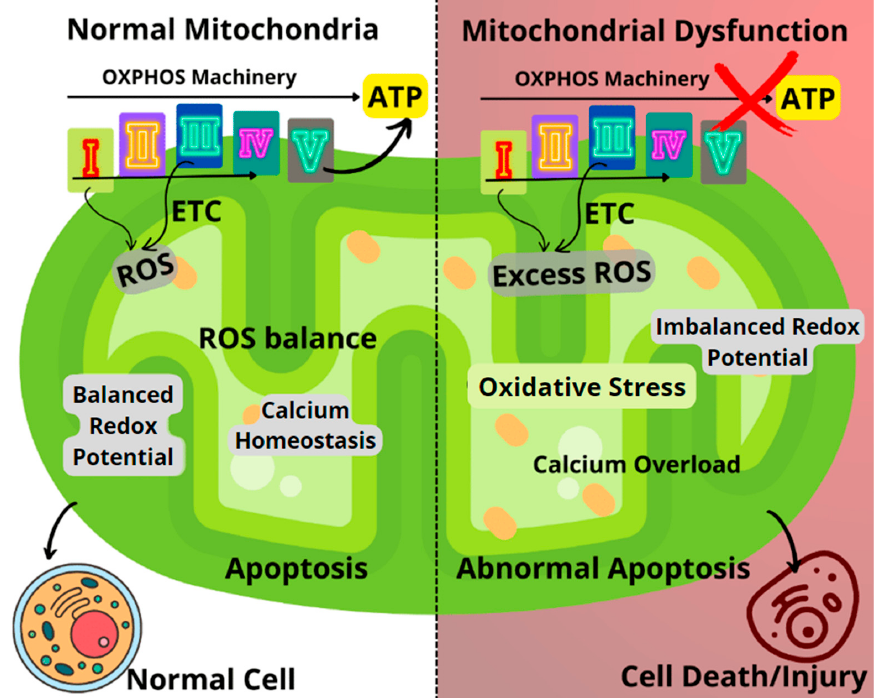
Figure 1. Comparison between healthy and dysfunctional mitochondria, highlighting the key mechanisms of mitochondrial dysfunction. ETC: Electron transport chain; ROS: Reactive oxygen species.